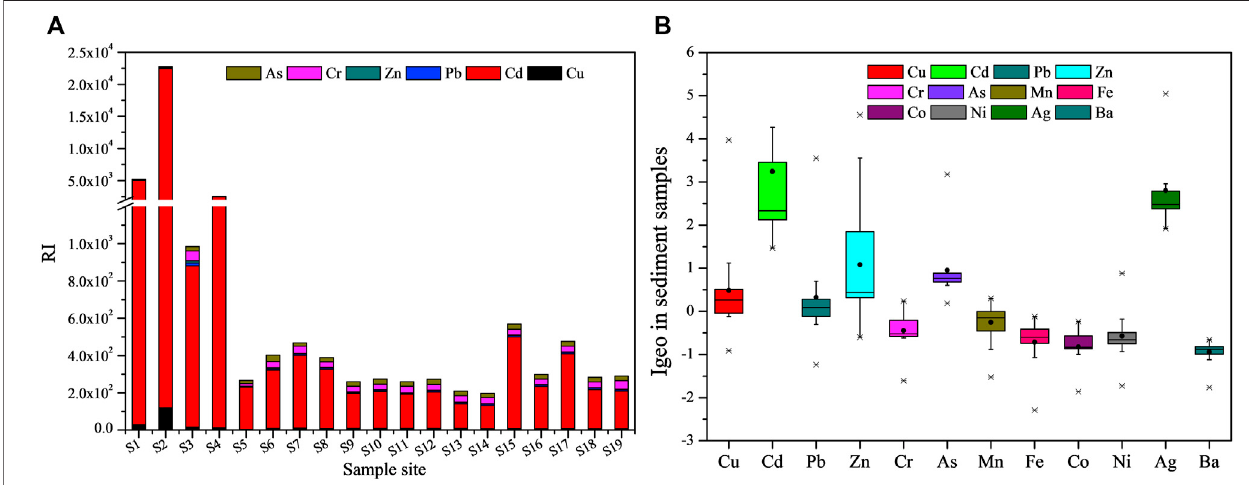
FIGURE 6 | Risk assessment for selected heavy metals in sediments: (A) RI of selected heavy metals in sediments. As: brownness; Cr: pink; Zn: green; Pb: blue; Cd: red;Cu: black. (B) Igeo ofselected heavymetalsinsediments.Thebox plotsdisplaythevaluesfromsurface.watersamples(median, 25and 75%quartiles[boxes], 10 and 90% percentiles